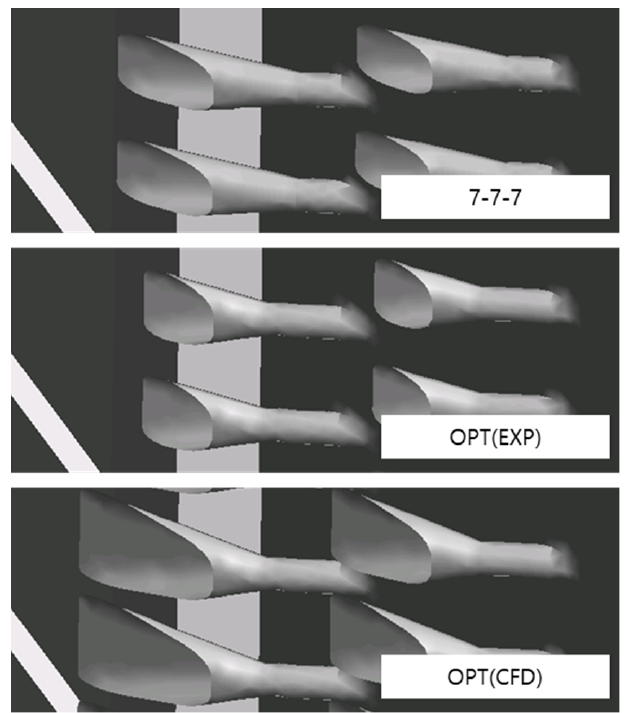
Figure 9. Three types of fan-shaped holes applied to the nozzle vane.